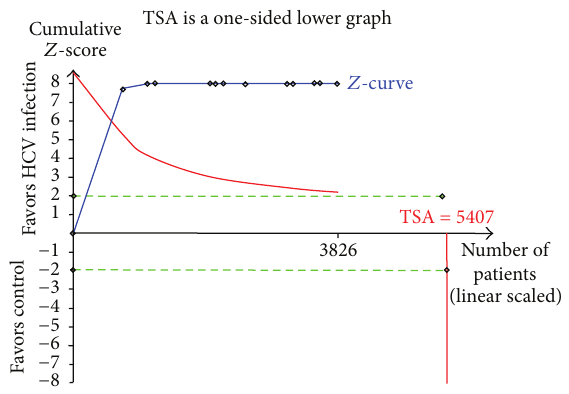
Figure 4: Trial sequence analysis of H. pylori infection in patients with HCV versus controls.